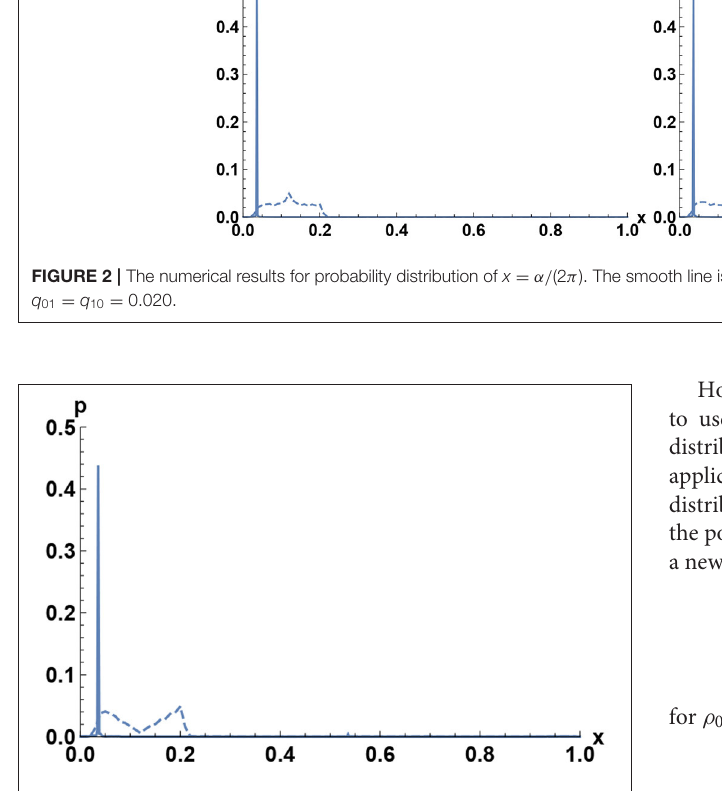
FIGURE 3 | The numerical results for probability distribution of x = α/ (2 π ), q 01 = q 10 = 0.03. The smooth line is ρ 0 ( x ), the dashed line ρ 1 ( x